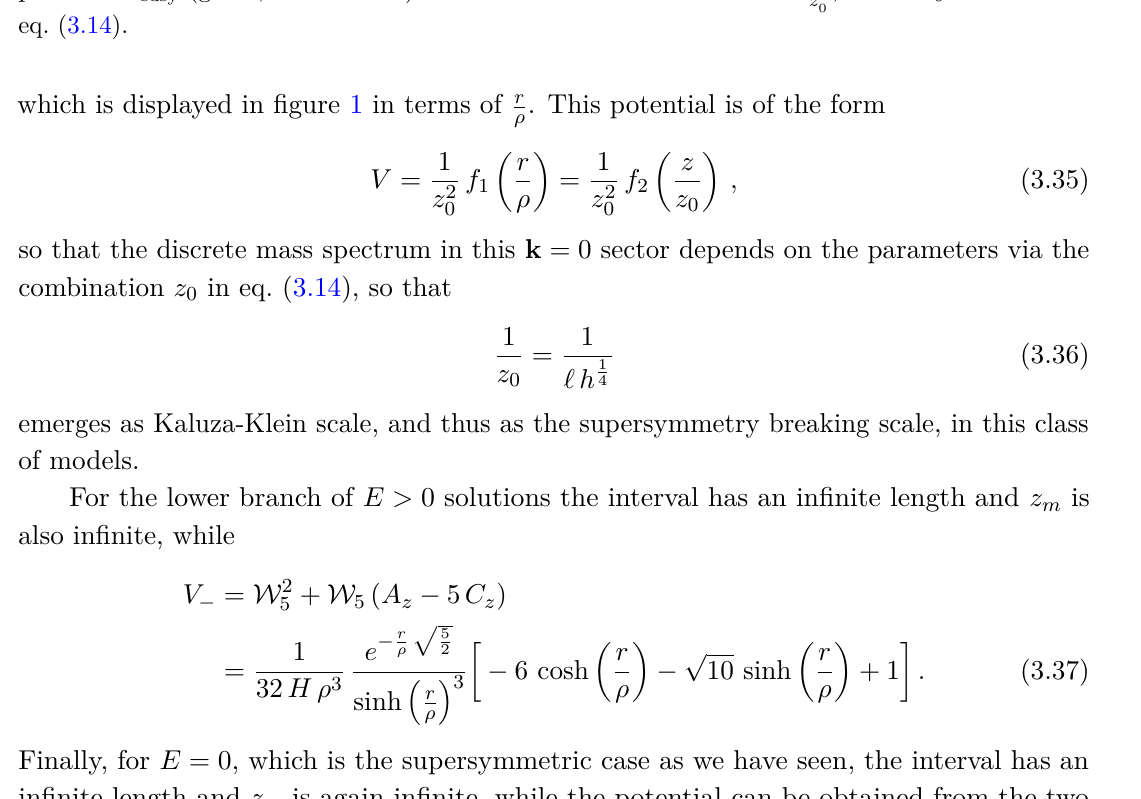
, where z is defined in 0 z 2 0